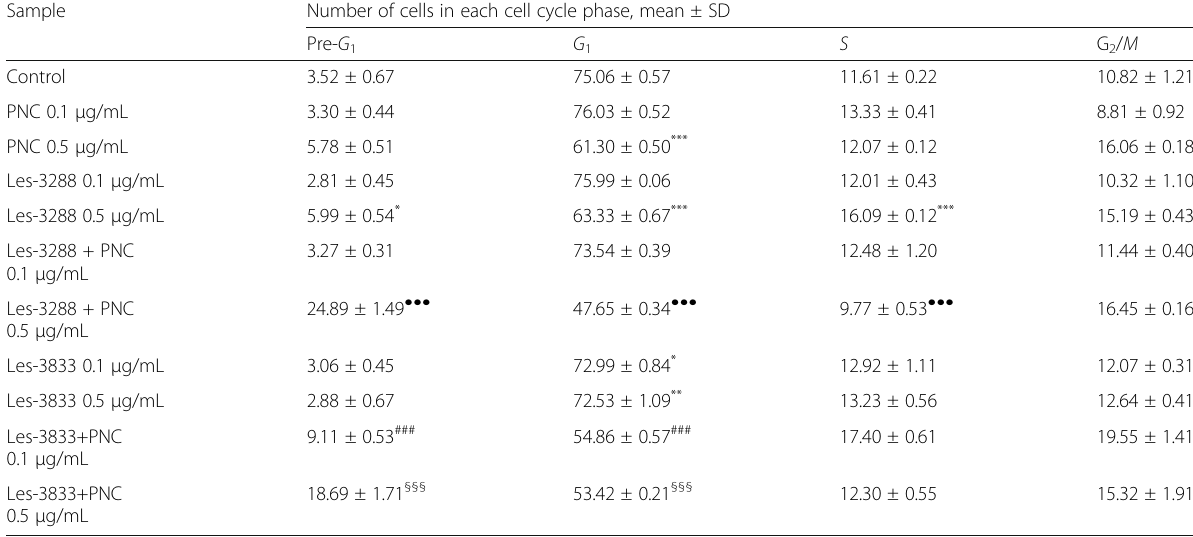
Table 1 Distribution of C6 rat glioma cells in different phases of the cell cycle under treatment for 24 h with 4-thiazolidinone derivatives Les-3288 and Les-3833 in free form and in complex with polymeric nanocarrier (PNC)